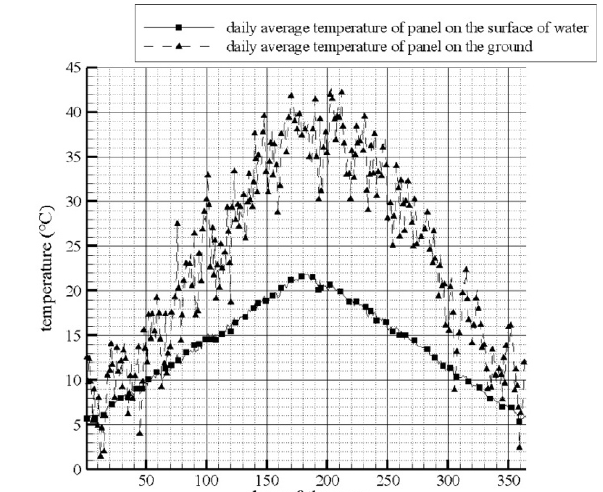
Figure 7. daily average temperature of panel on the water surface and on the ground